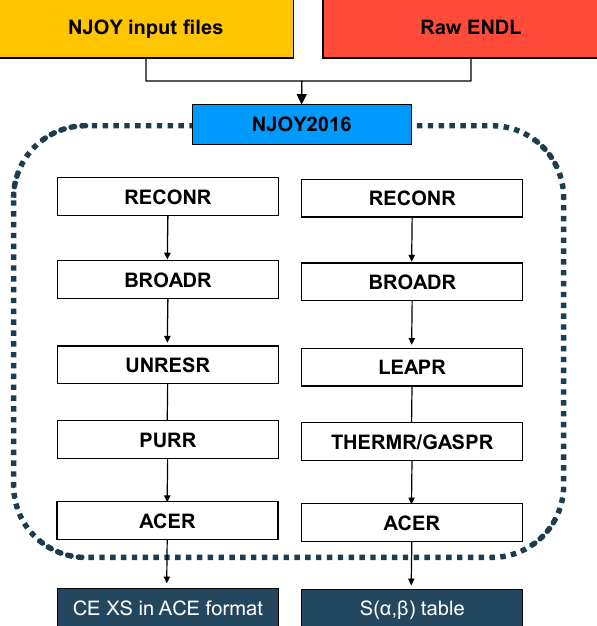
Figure 1. A flowchart of Monte Carlo CE library generation in NJOY code.